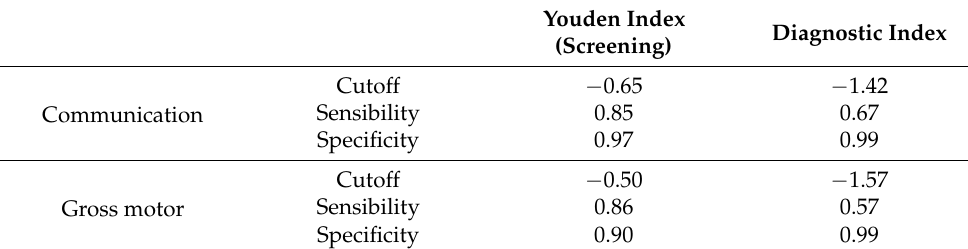
Table 11 showed the two cut-off values identified by the ROC analyses: the Youden’s index has been used as a screening index, whereas a diagnostic index has been identified using the criterion of specificity = 0.99. Table 11. Cut-off the Italian version of ASQ-3